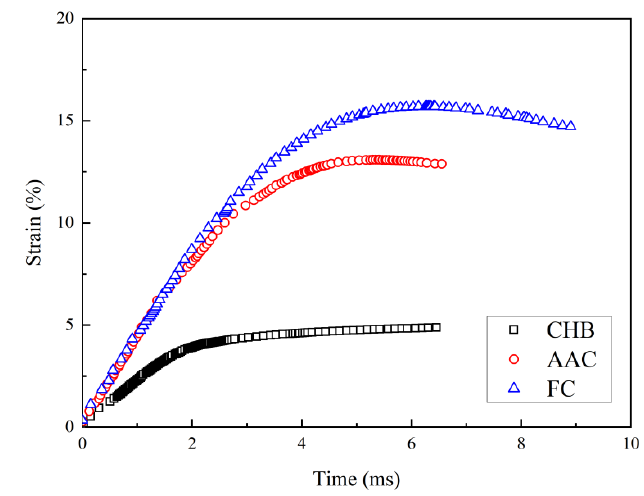
Figure 4. Development of strain with time during drop-weight tests.